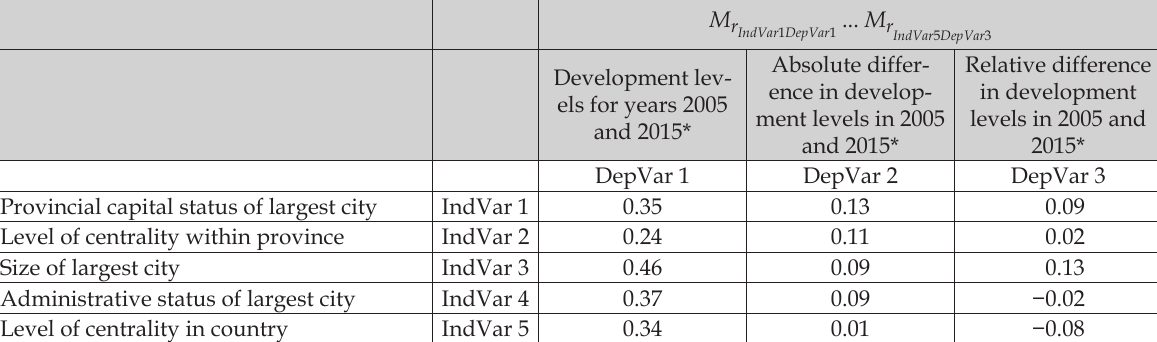
Table 1. Mean values of the Pearson correlation